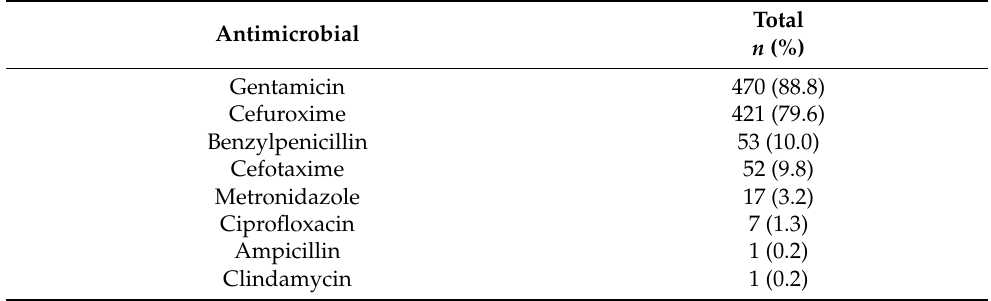
Table 3. Distribution of empirical antimicrobials prescribed for neonates admitted for suspected sepsis at Komfo Anokye Teaching Hospital, Ghana, between January 2021 and December